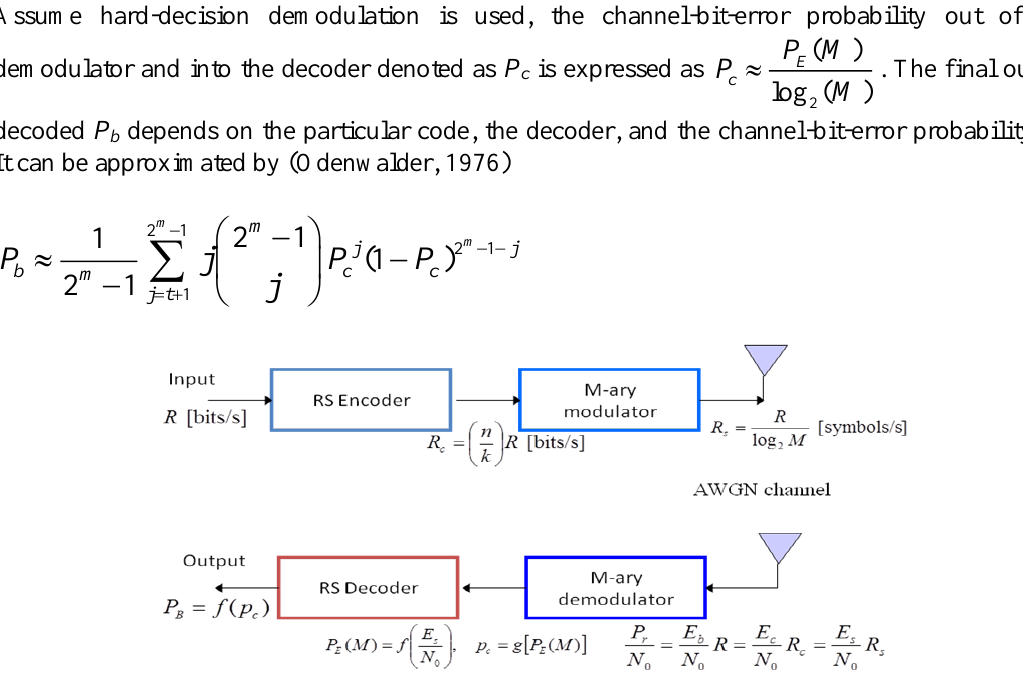
Figure 2. Basic modulator/demodulator with channel coding (Sklar,